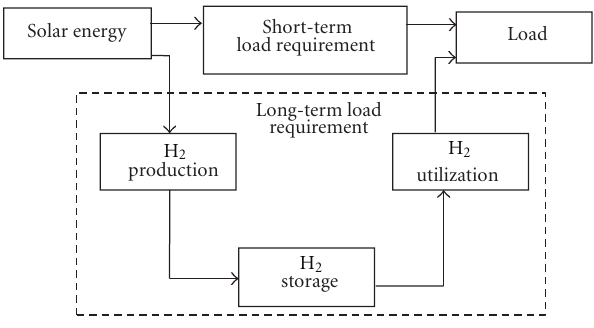
Figure 1: Long- and short-term power supplying for solar hydrogen systems